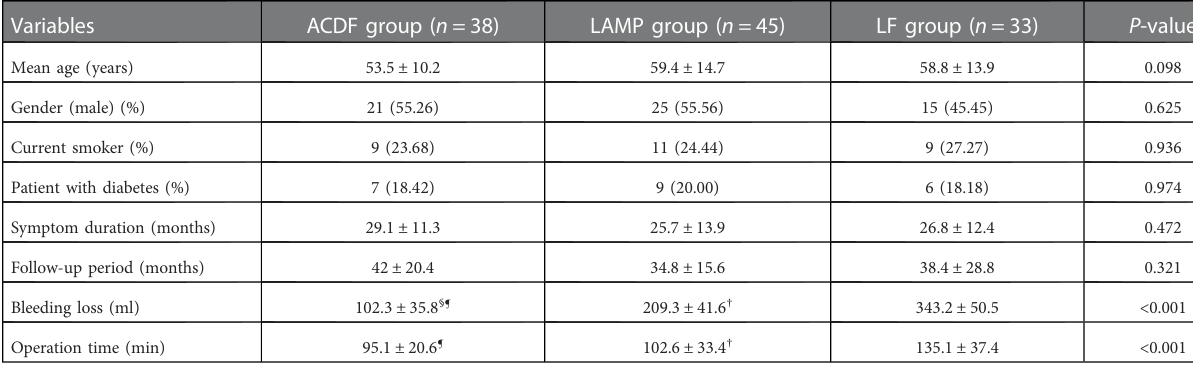
TABLE 1 Demographic and surgical data of